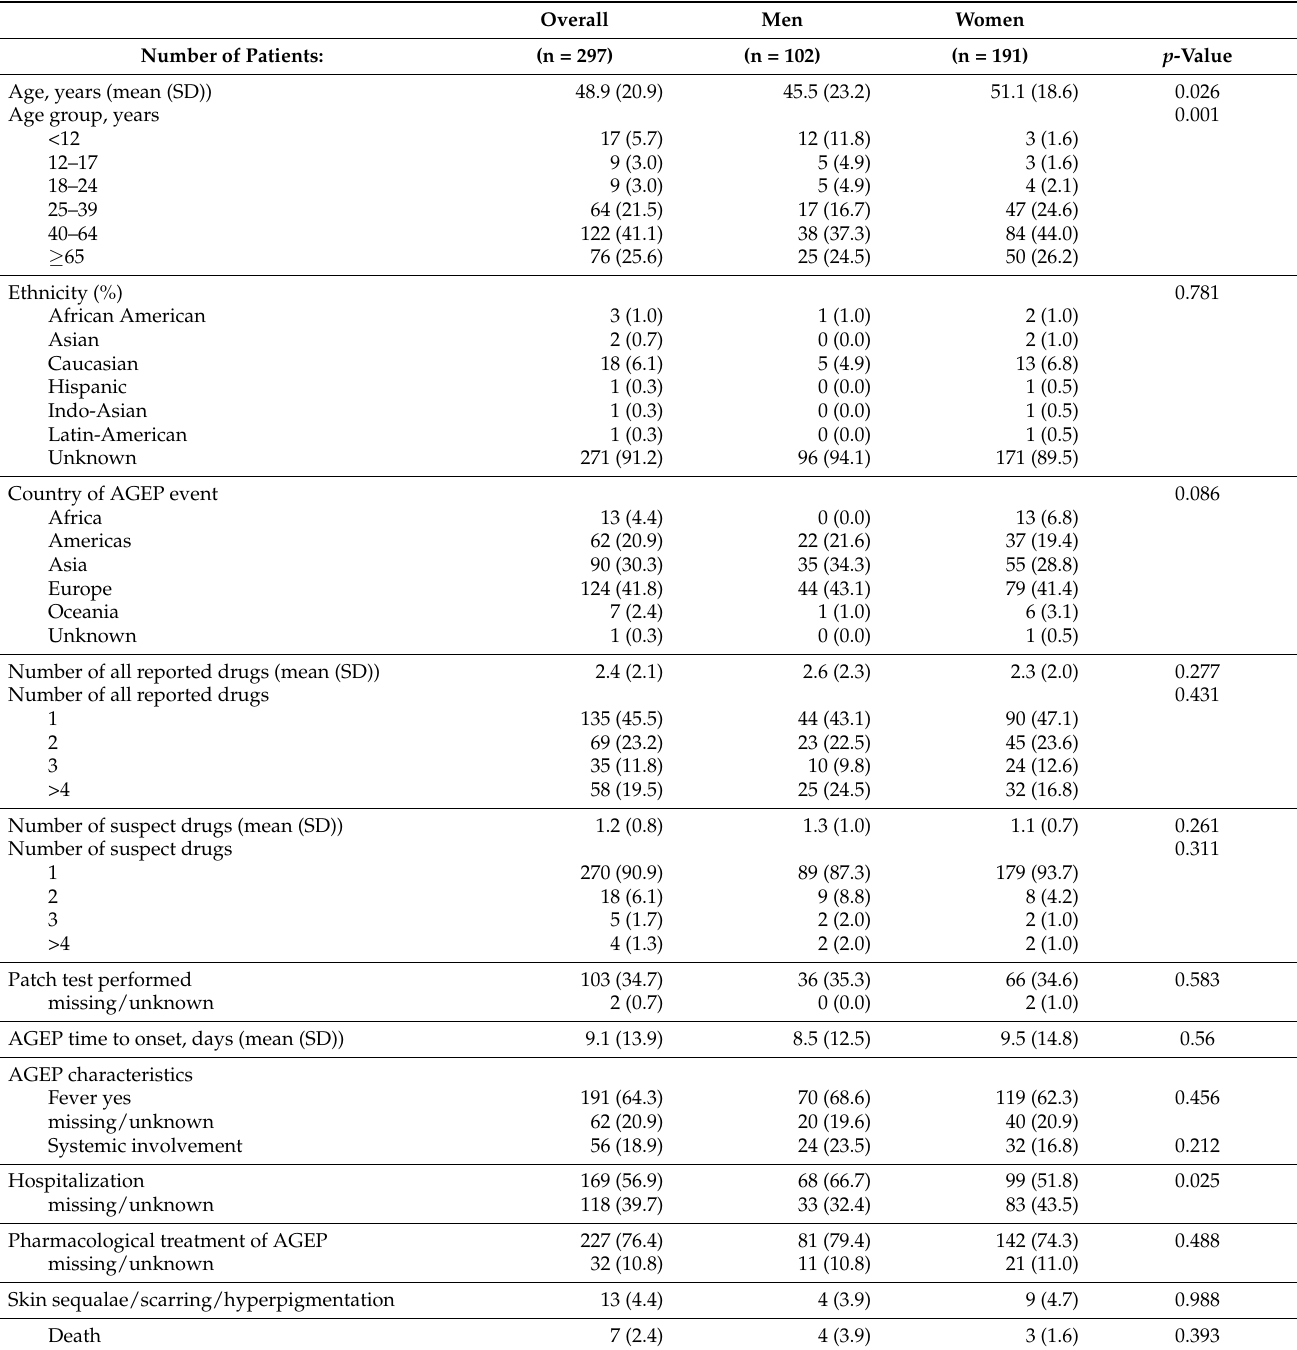
Table 1. Characteristics of the included patients with acute generalized exanthematous pustulosis